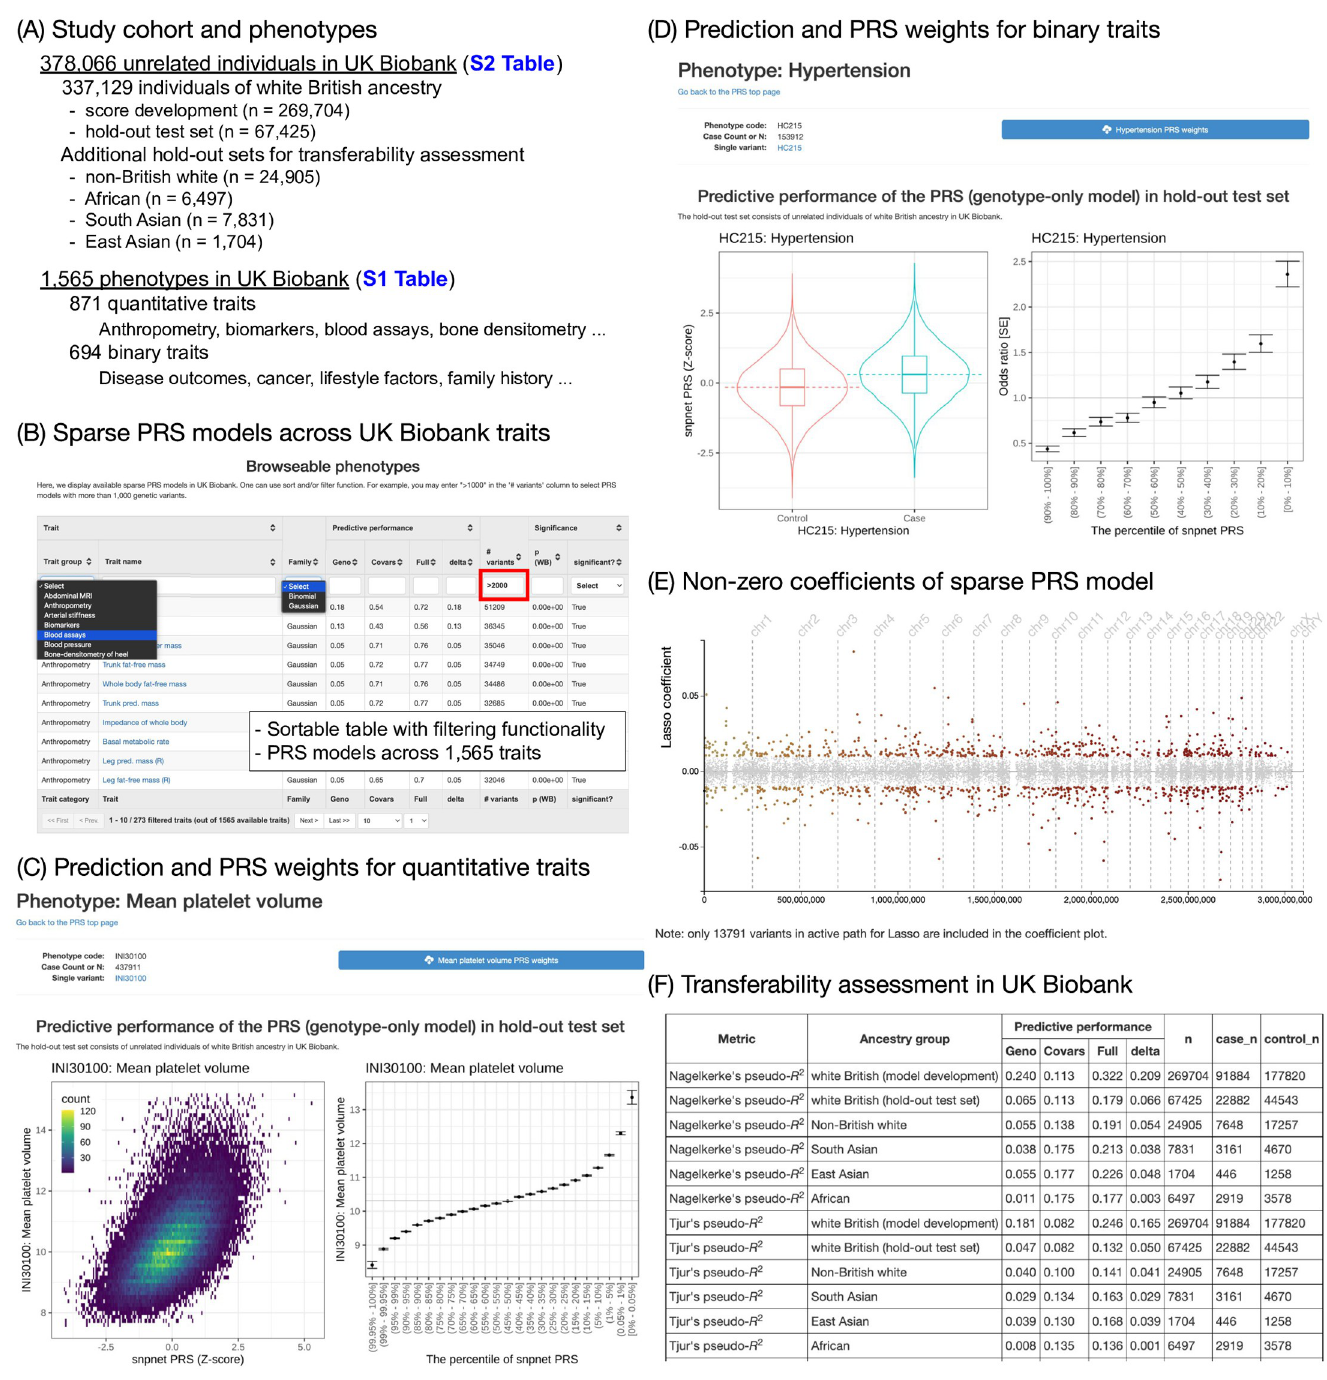
Fig 1. Significant sparse polygenic risk scores (PRSs) across 813 traits in the UK Biobank. (A) We analyzed a total of more than 378,000 unrelated individuals and 1,565 traits in UK Biobank. We used 80% of individuals of white British ancestry for score development. For evaluation, we used the remaining 20% of individuals and additional individuals in other ancestry groups. (B) The full list of 1,565 traits with predictive performance is shown as a sortable table at Global Biobank Engine (https://biobankengine.stanford.edu/prs). (C) The predictive performance of PRS models for quantitative traits is summarized as a heatmap comparing the predicted risk score (Z-score) and observed trait value (left) and mean and standard error of trait values stratified by percentile bin (right). (D) The predictive performance of PRS models for binary traits is summarized as PRS score distribution stratified by case/control status (left) and odds ratio stratified by percentile bin (right). (E) The non-zero coefficients of the sparse PRS model are shown. (F) The predictive performance evaluation in training and test sets consist of individuals of white British ancestry, as well as additional sets consisting of individuals from non-British white, African, South Asian, and East Asian ancestry groups in the UK Biobank.